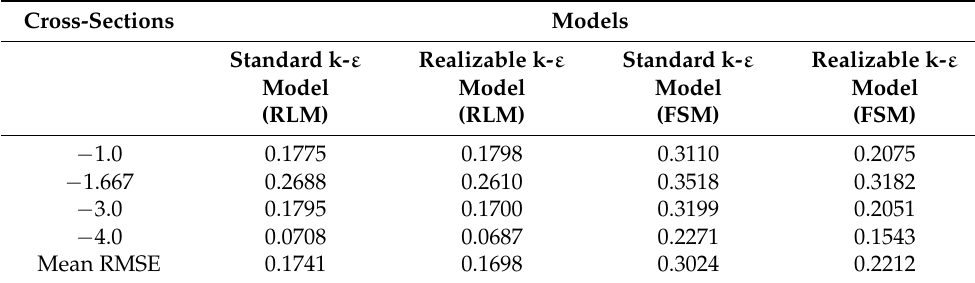
Figure 17. Resultant velocities across dimensionless transverse distance for confluent channel ( a ) at x* = − 1.0 ( b ) at x* = − 1.667 ( c ) at x* = − 3.0 ( d ) at x* = − 4.0. Table 5. RMSE estimation for the resultant velocities in Figure 17.